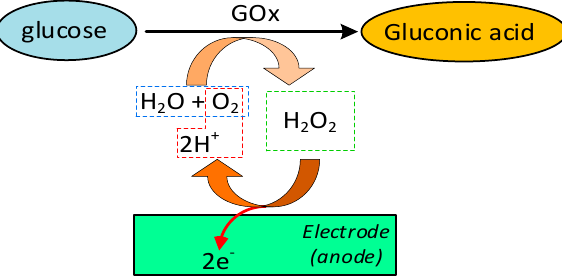
Figure 2. Enzymatic-amperometric method for measurement of glucose concentration in-vitro.